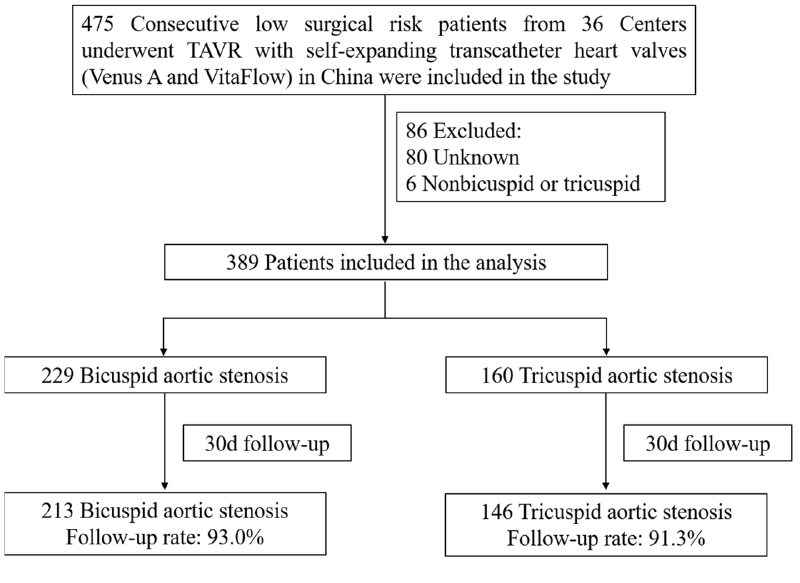
Figure 1. The design of the